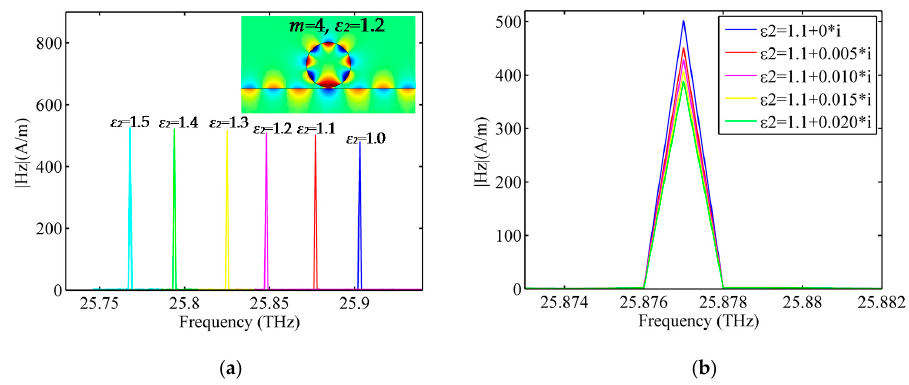
Figure 8. The resonant frequency spectra of mode 4 for a variation of the real part ( a ) and imaginary part ( b ) of analyte permittivity. The inset denotes the magnetic-field (H z ) distribution at the resonant state when ε 2 = 1.2.